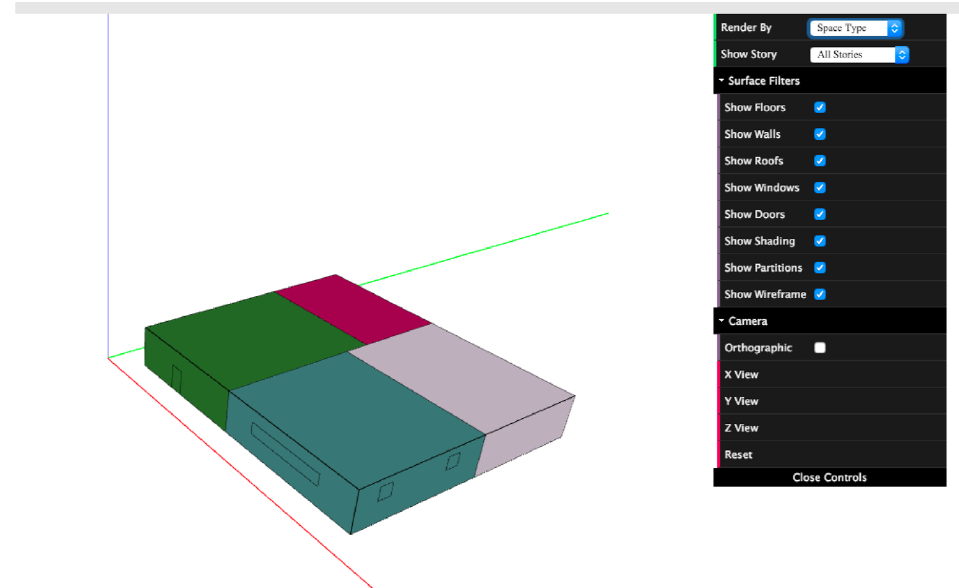
Figure 7. OpenStudio diagram of the four different space type declarations, where each different space type will have different properties such as electrical usage.